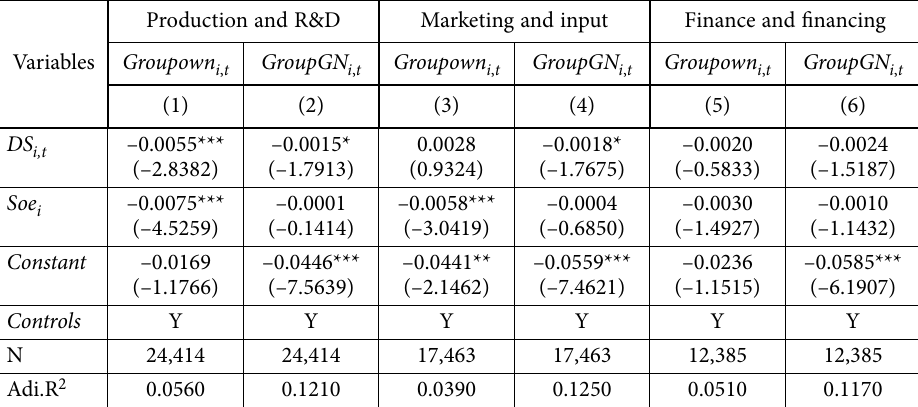
Table 7. Asymmetries in the six dimensions of the three major areas of corporate strategy deviation